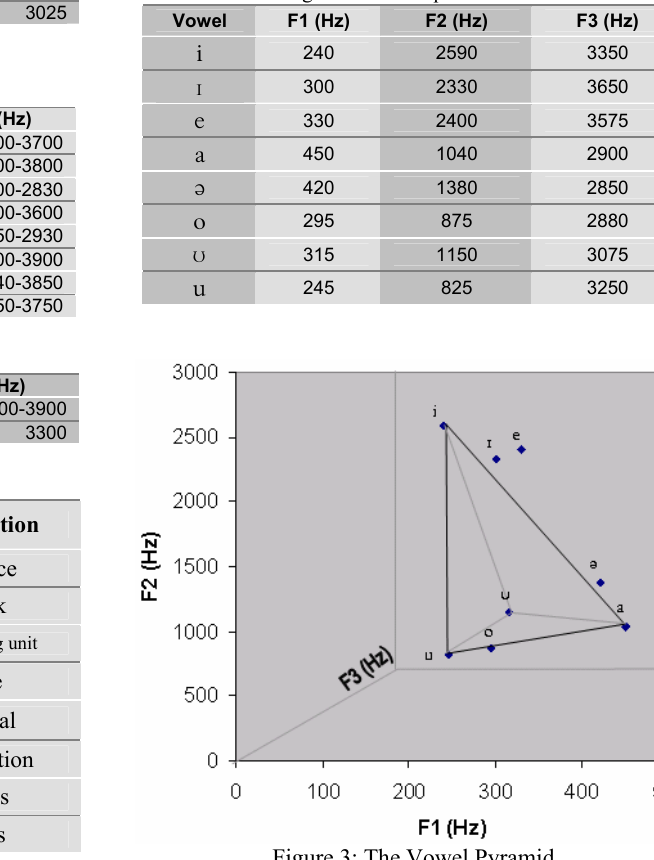
Table 25: Average formant Frequencies for Sindhi Vowels